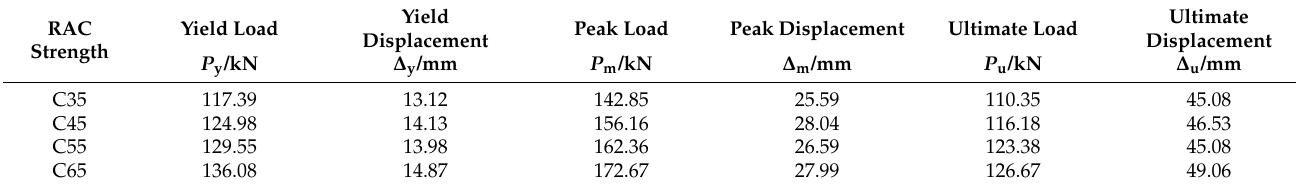
Table 5. Influence of RAC strength on characteristic points of composite joints.